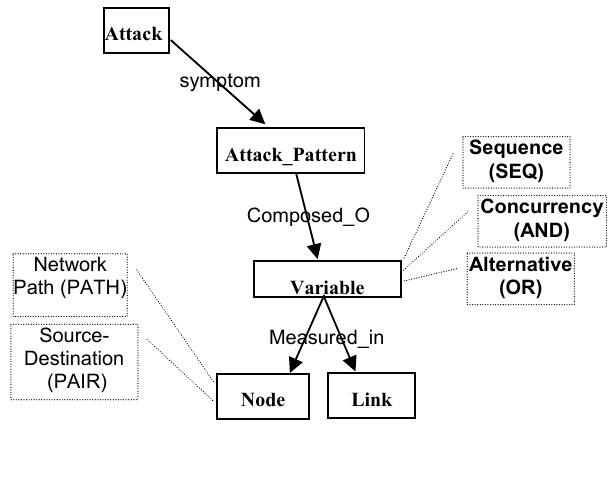
Fig. 1. Core attack pattern ontology